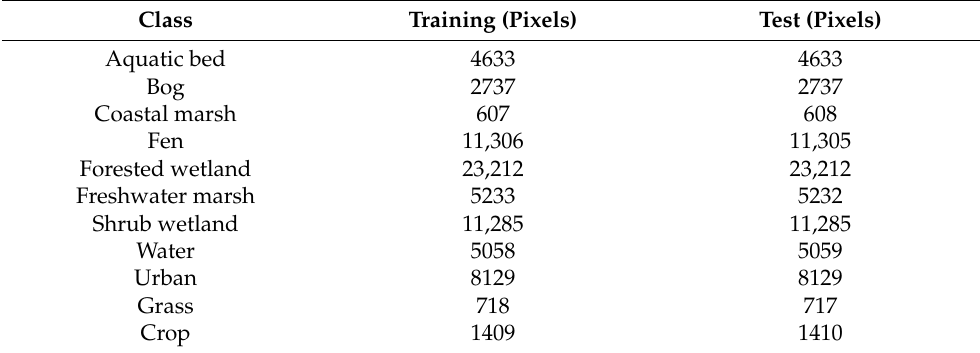
Table 1. The number of training and test pixels for the wetland and non-wetland classes in the pilot site of Saint John, New Brunswick, Canada. Class